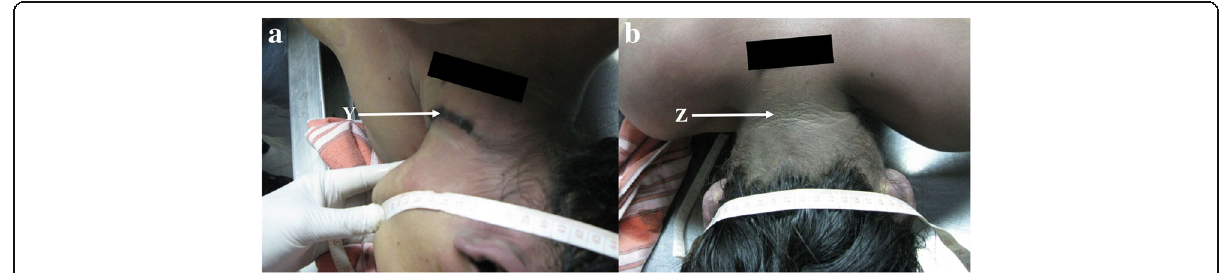
Fig. 4 a Right side of the neck with friction abrasions running upwards towards back of the neck, and it was deeply grooved on the anterior side (indicated by arrow Y ) with the impressions seen minimally towards back (indicated by arrow Z ). There were no edema, congestion, or petechial hemorrhage above the constriction mark. b Back aspect, ligature mark impressions seen minimally under the